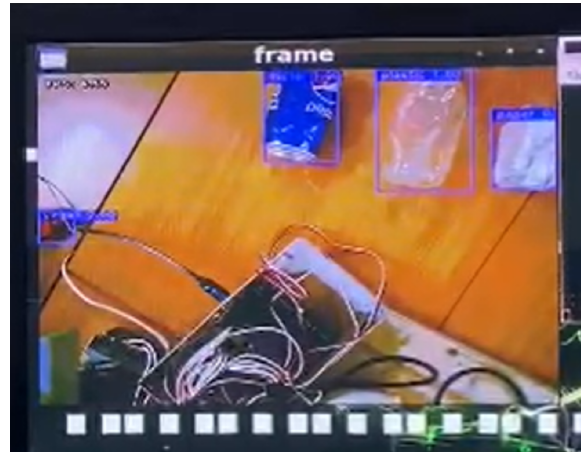
Fig. 11. The image identifies the types of waste on the image